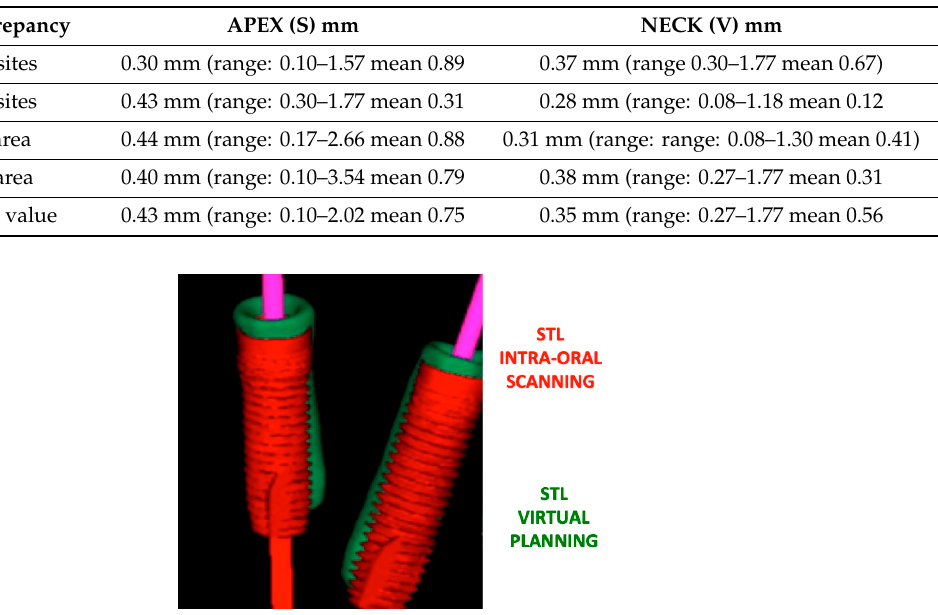
Table 2. The horizontal apex (S) and neck (V) implant discrepancies.